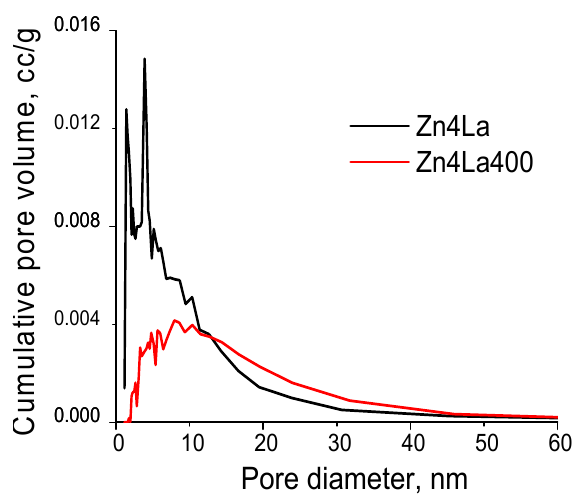
Figure 6. Pore size distribution of the samples obtained by applying the BJH model.